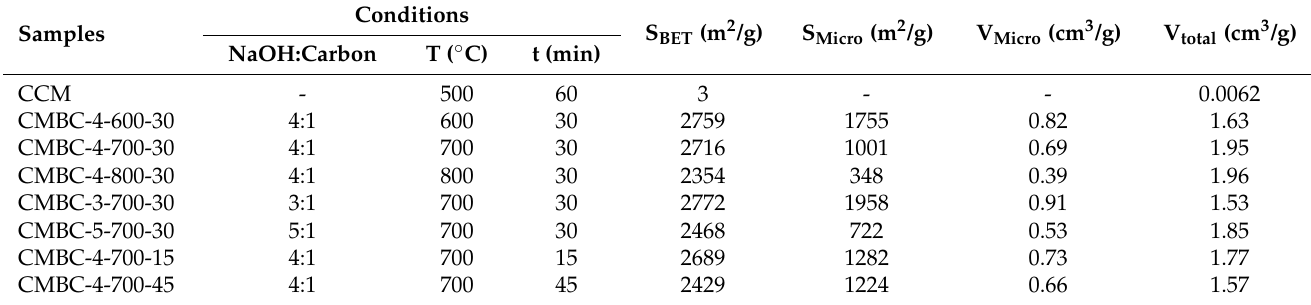
Table 1. The data of N 2 adsorption-desorption for CCM, CMBC prepared under different conditions.